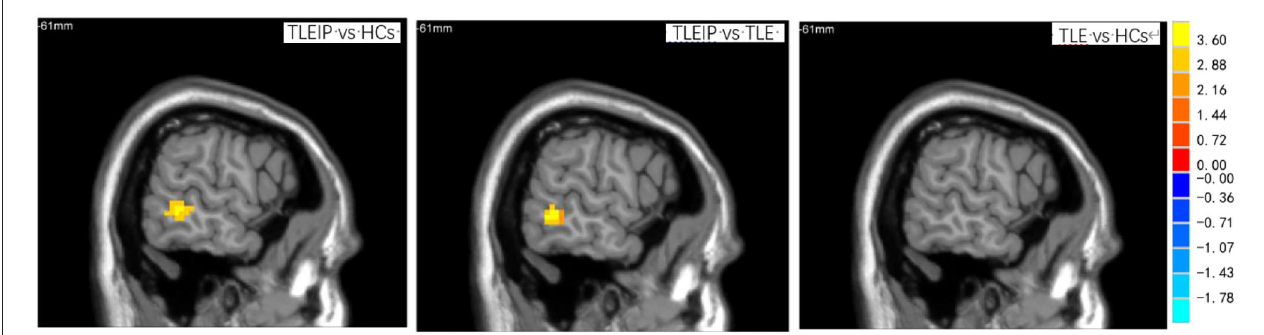
FIGURE 2 | The DC differences among TLEIP, TLE without IP, and HCs. Compared to the HCs and TLE without IP groups, the DC value of the TLEIP group in the left middle temporal gyrus (LMTG) was significantly increased (GRF correction, two-tailed, voxel level P < 0.001, cluster level P < 0.05).